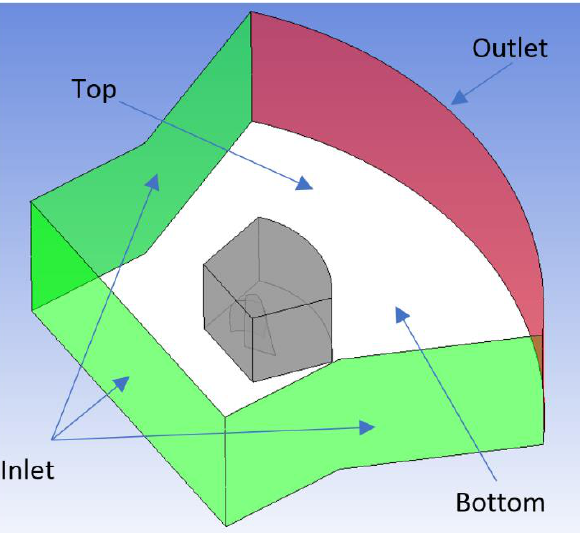
Figure 2. CFD domain: boundary surfaces (top is fully transparent, bottom is white), and inner (grey) and outer regions.